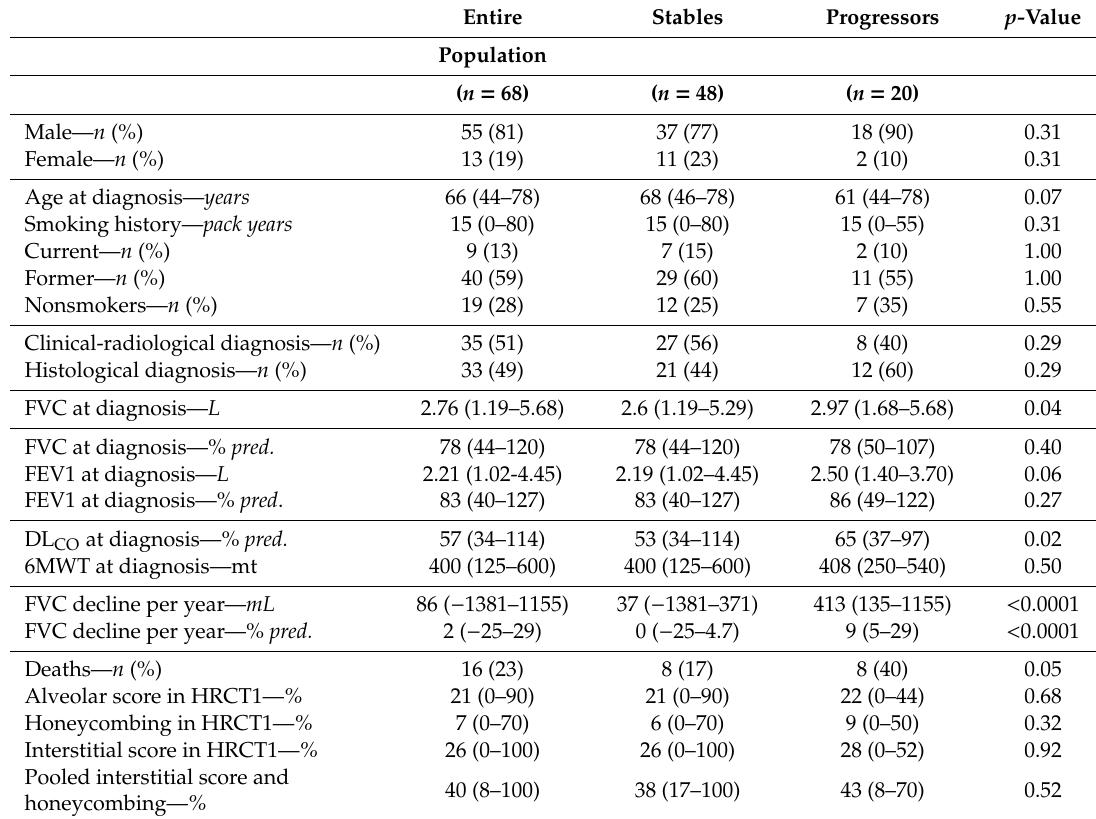
Table 1. Patients demographics and clinical